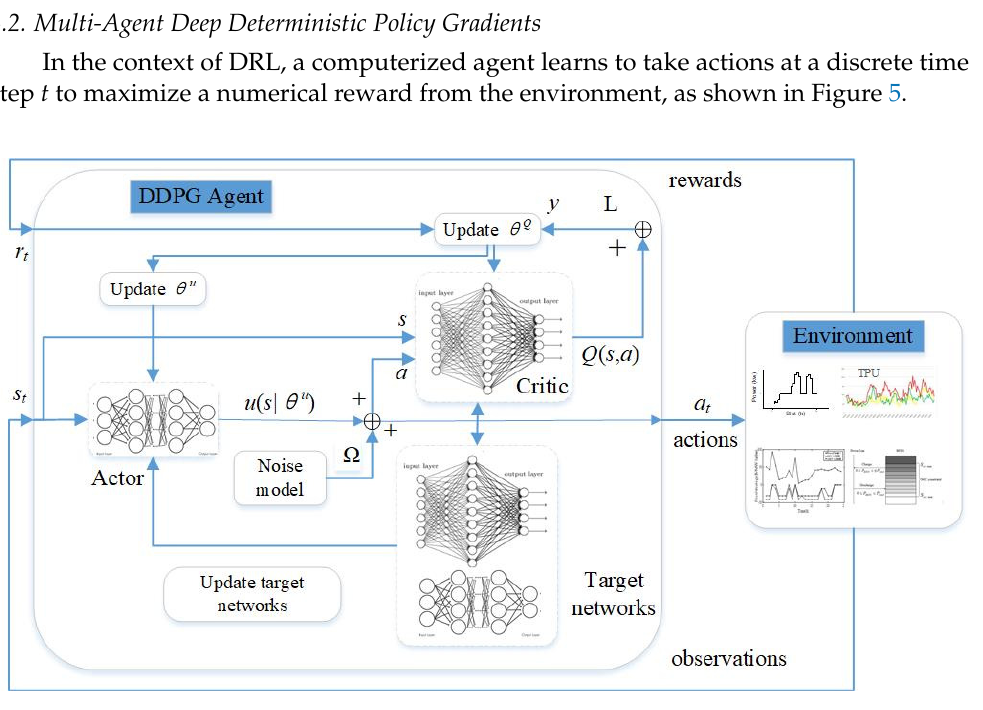
Figure 5. Structure of a DRL agent trained with the DDPG algorithm.